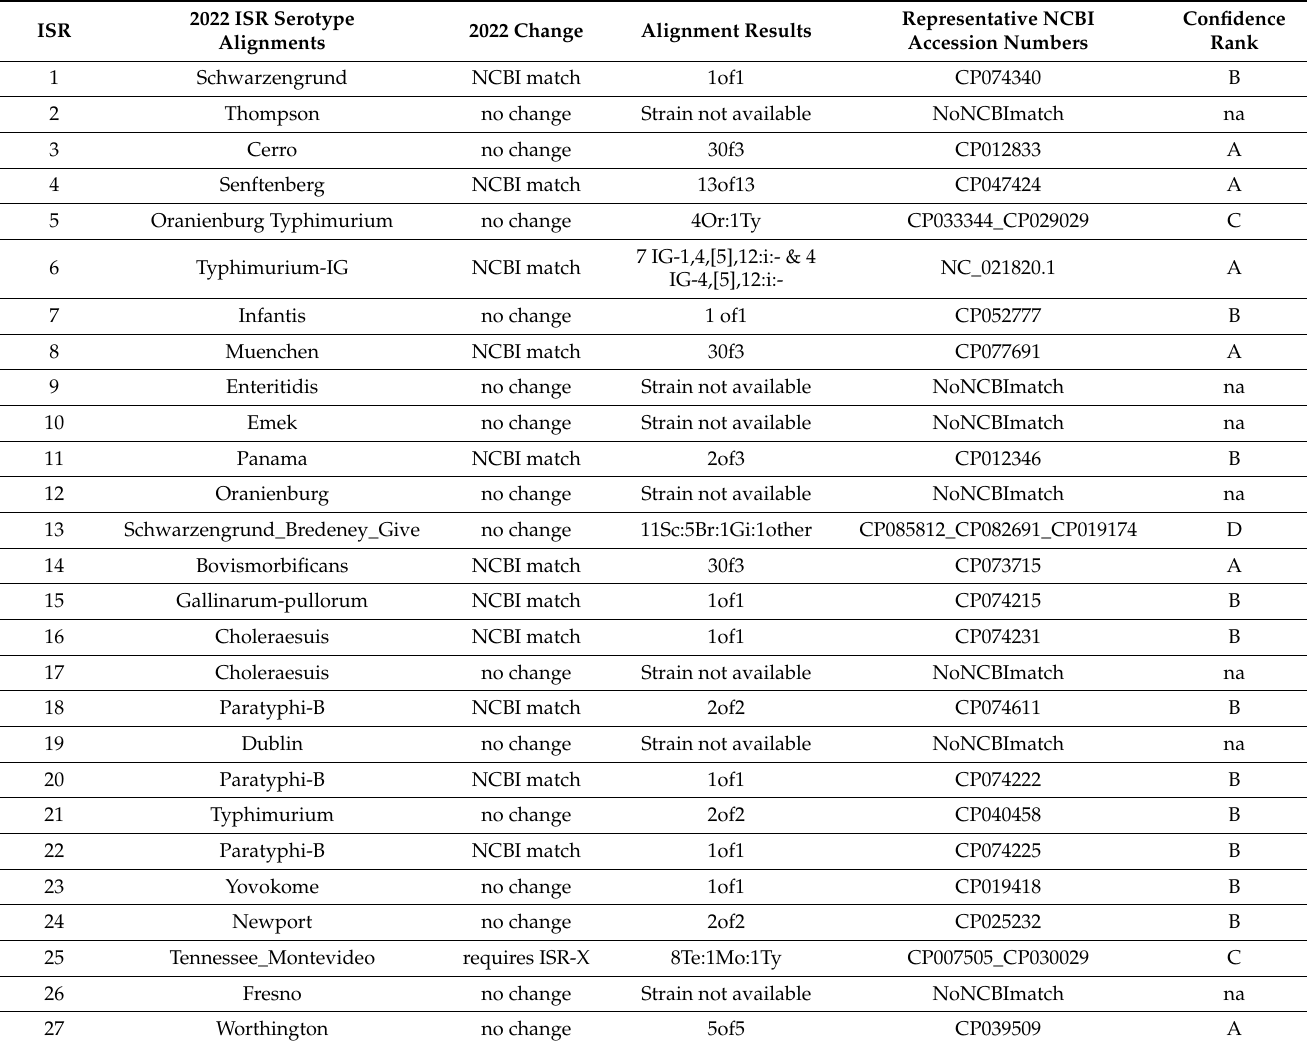
Table 1. Changes to the Salmonella enterica subspecies I Intergenic sequence ribotyping (ISR) database for screening serotype: 2012 versus